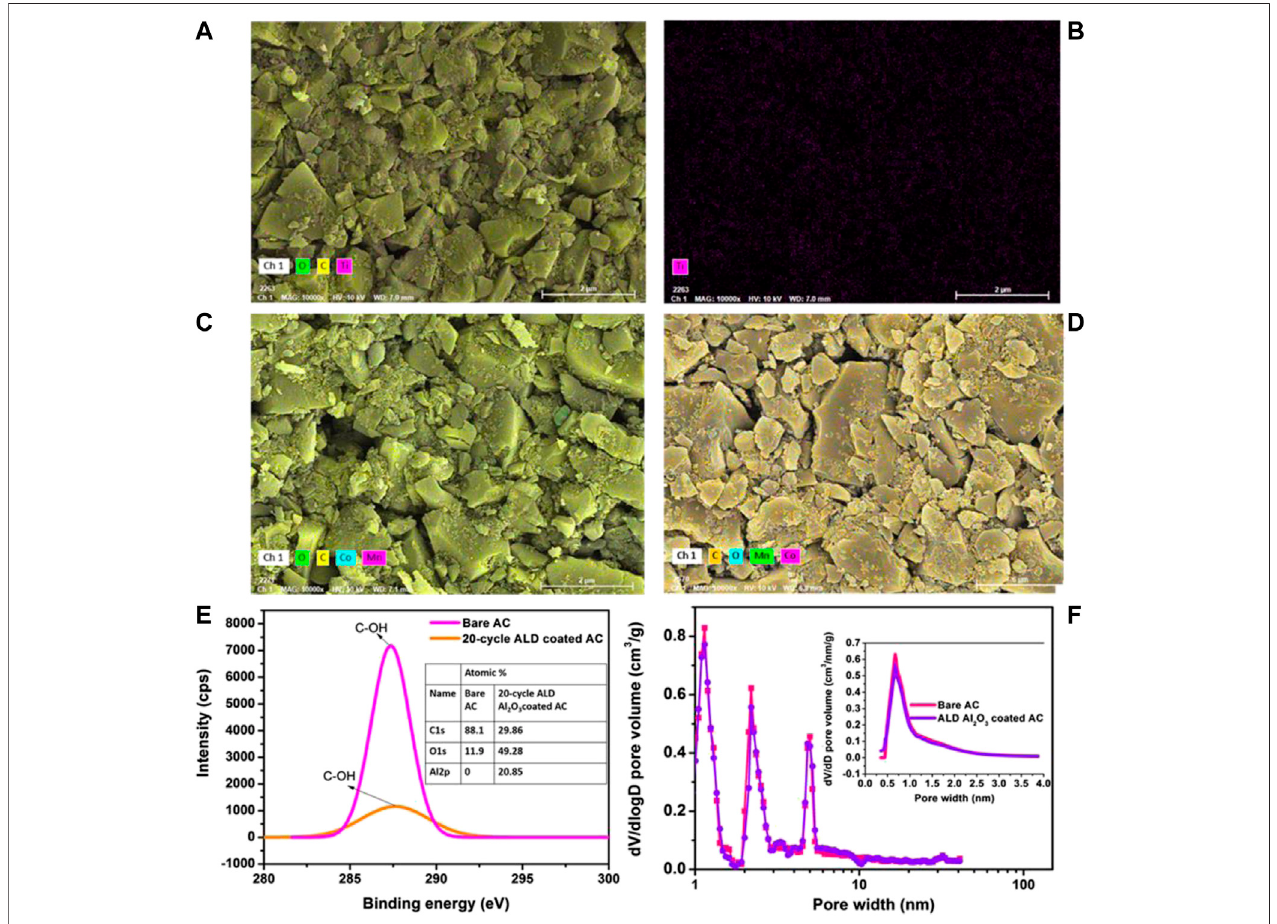
FIGURE 3 | SEM images for AC electrodes coated with TiO 2 − x (A,B) and MnCo 2 − x O 4 (C,D) . (E) XPS C 1 s spectrum (C-OH) of AC before and after ALD modi fi cation, theinsetshows atomic% of various elements. (F) Pore sizedistribution ofbare ACand ALD modi fi ed ACusing DFT method and the insetshows their pore distribution by HK